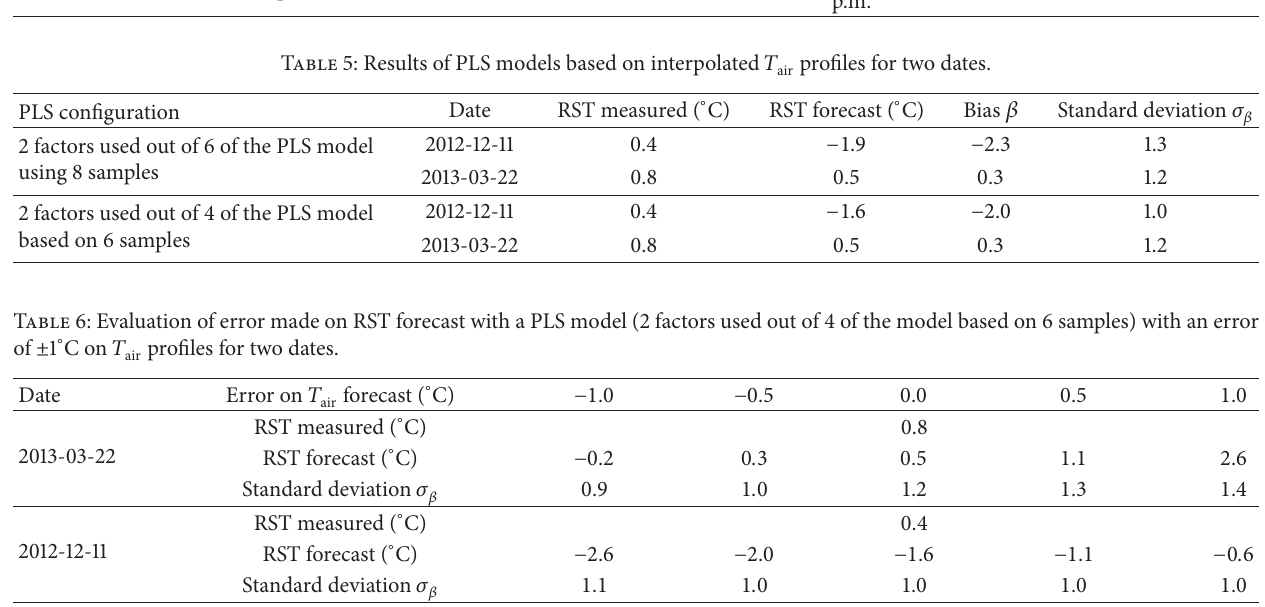
Table 5: Results of PLS models based on interpolated 𝑇